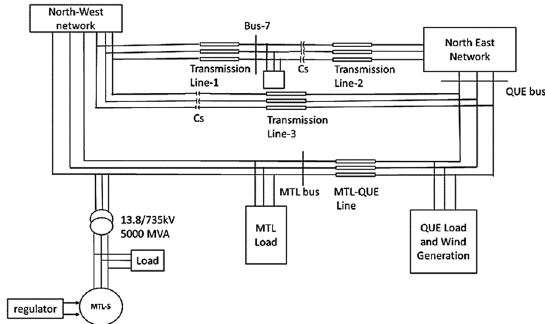
Table 7 Comparison of the proposed algorithm with